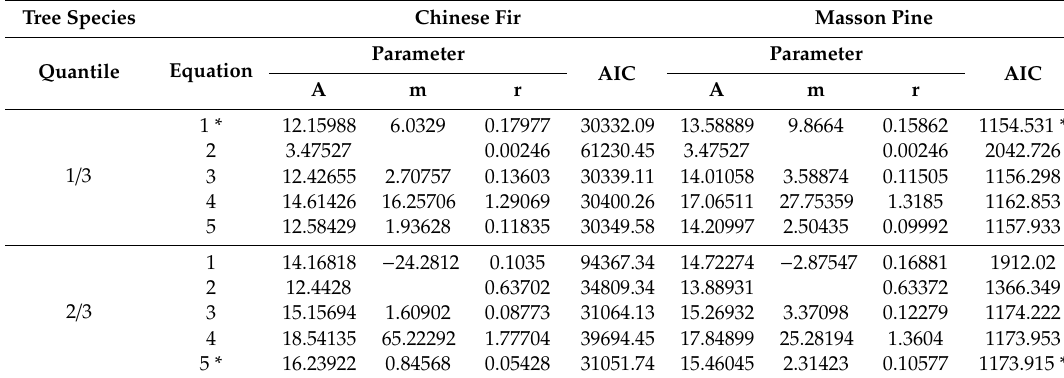
Table 6. Fitting results of AGE-H-Quantile method.